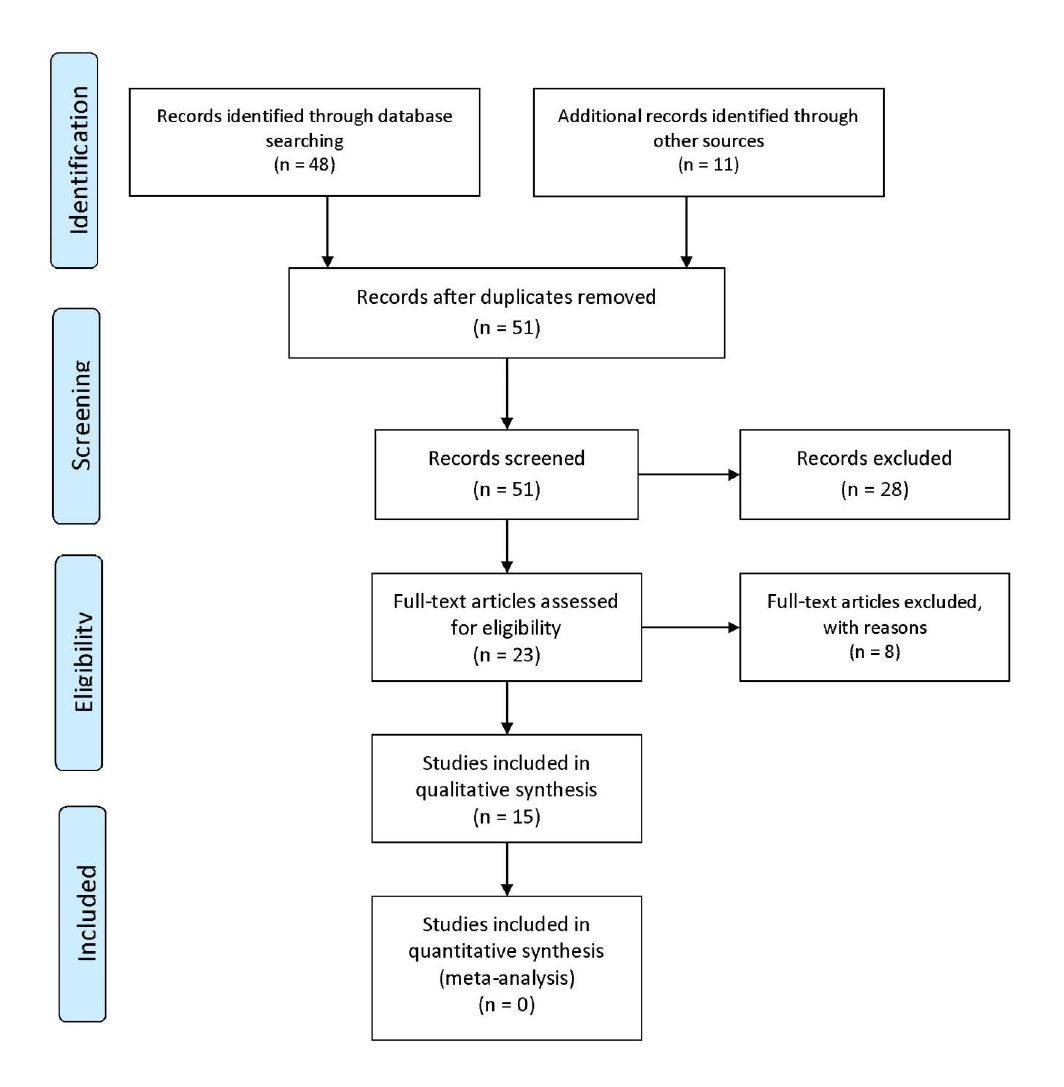
Figure 1. PRISMA flowchart Data extraction and